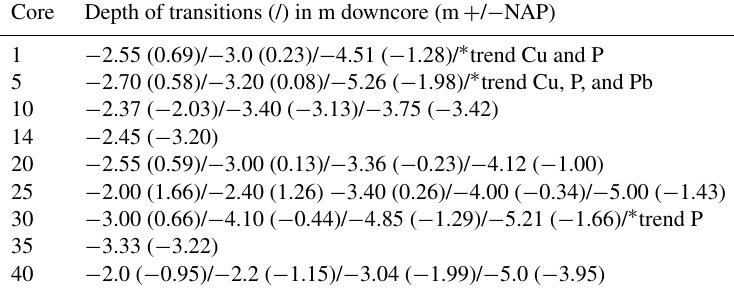
Table 5. Depth of transitions P, Cu, and/or Pb as measured by a handheld XRF analyser indicated in metres downcore and relative to NAP. In three cores trends of slightly increasing elements below the basal transition are indicated ( ∗ ). (“/” indicates multiple changes in sediment layer.)